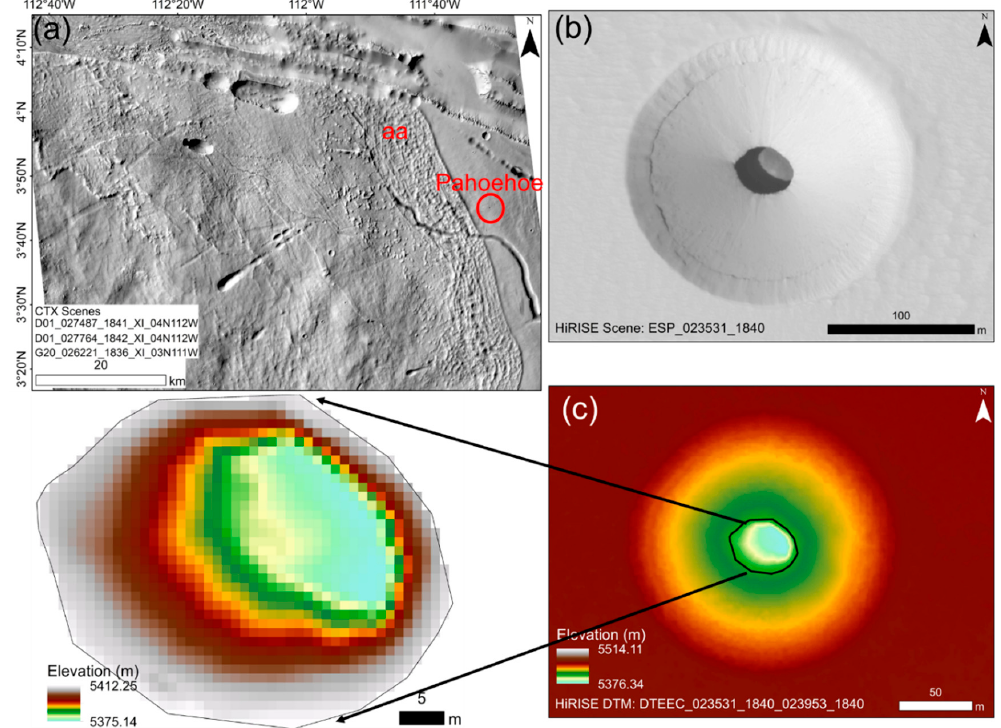
Figure 10. A huge pit crater in the lava field of Pavonis Mons: ( a ) contextual map generated using CTX mosaic and showing the cave location along with the lava flow morphologies and channels; ( b ) HiRISE view of the cave opening; ( c ) HiRISE DTM showing elevation changes in and around the cave opening. The image IDs are provided within the maps. CTX image credit: NASA/JPL-Caltech. HiRISE image credit: NASA/JPL/University of Arizona.